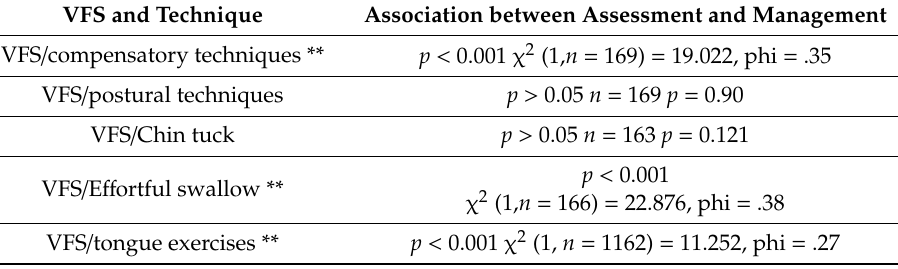
Table 4. Relationship between assessment and management